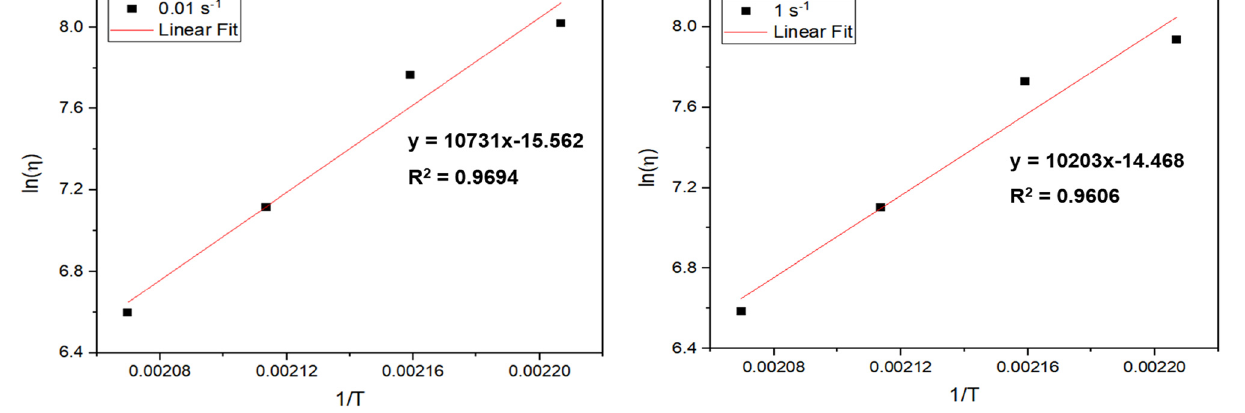
Figure 3: Plot of ln ( viscosity ) versus 1/ T for the PLA at 0.01/s shear rate.